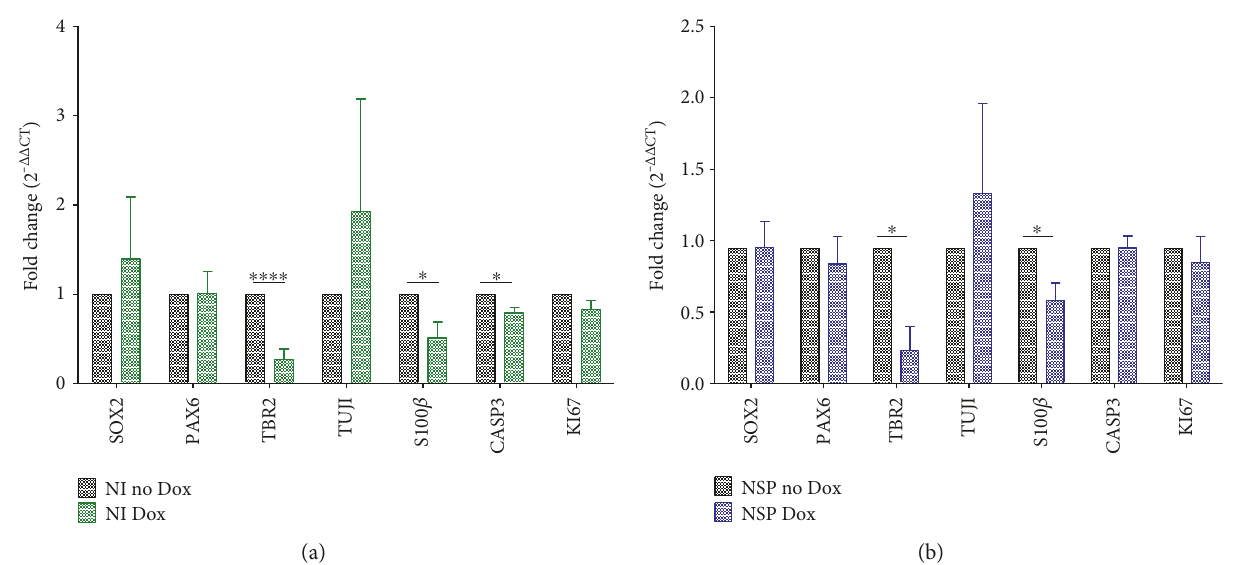
Figure 3: WDR62 knockdown e ff ects hPSC speci fi cation to neural and glial progenitors. (a) Q-PCR data suggest signi fi cant reduction of TBR2 ( P = 8 0 E − 04 ), S100 β ( P = 0 03 ), and CASP3 ( P = 0 02 ) expression in Dox-treated WDR62 shRNA-transduced hPSC-derived neural progenitors treated with Dox versus no treatment at day 14 neural induction ( N ≥ 3 independent experiments). Two-tailed t -test was used to assess signi fi cance. (b) Similarly, Q-PCR data suggest signi fi cant reduction of TBR2 ( P = 0 01 ) and S100 β ( P = 0 01 ) expression in Dox-treated versus no Dox treatment at the NSP stage ( N ≥ 3 independent experiments, > 3 NSPs per experiment). Two- tailed t -test was used to assess signi fi cance. ∗ P < 0 05 ; ∗∗∗∗ P < 5 0 E − 05 . NI: neural induction; NSPs: neurospheres; Dox: